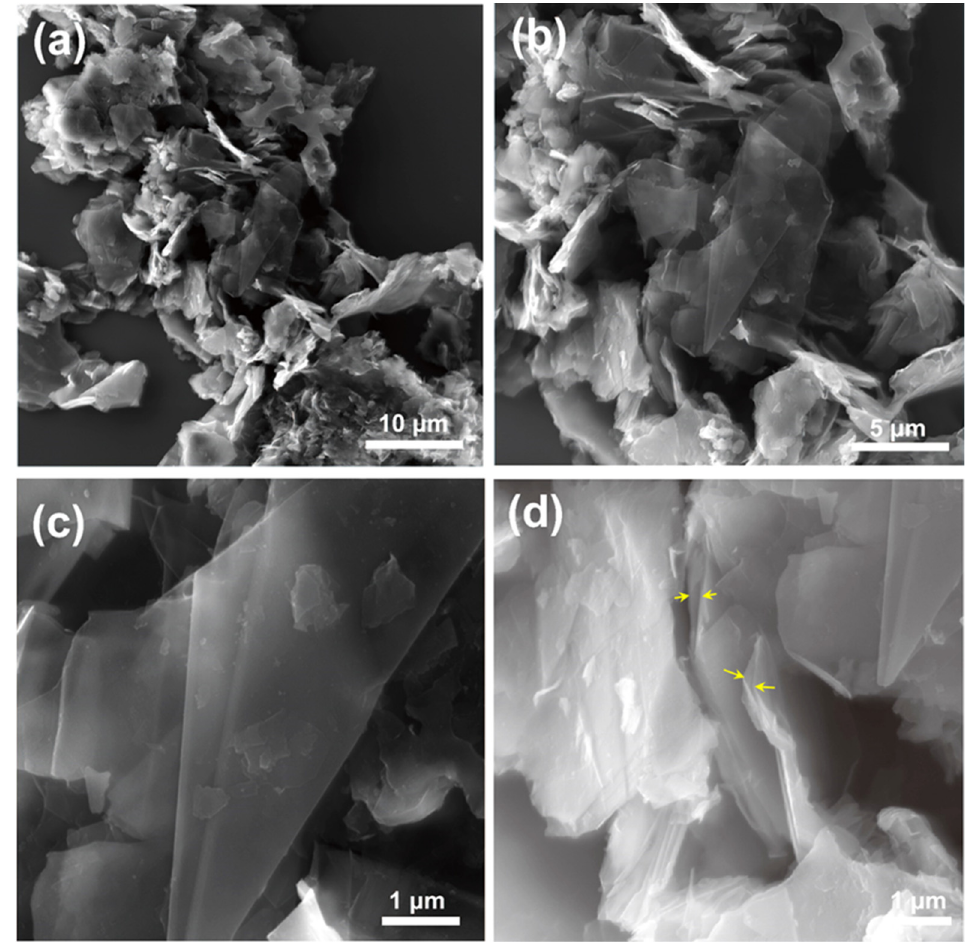
Figure 9. ( a – d ) SEM images of the tri-enzymatic system on bio-Graphene (yellow arrows shows the interlayer space of graphene flakes).